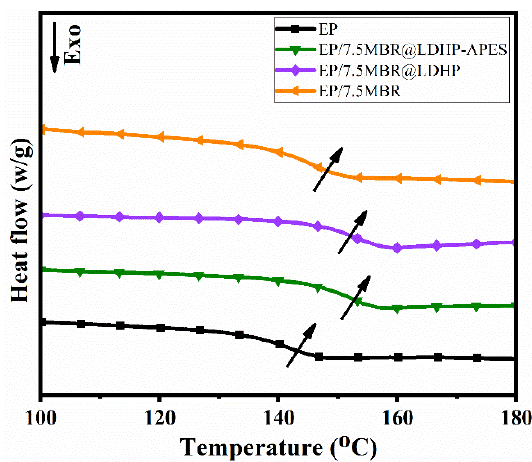
Figure 5. DSC curves for EP and EP/7.5MBR@LDHP-APES, EP/7.5MBR@LDHP, EP/7.5MBR.